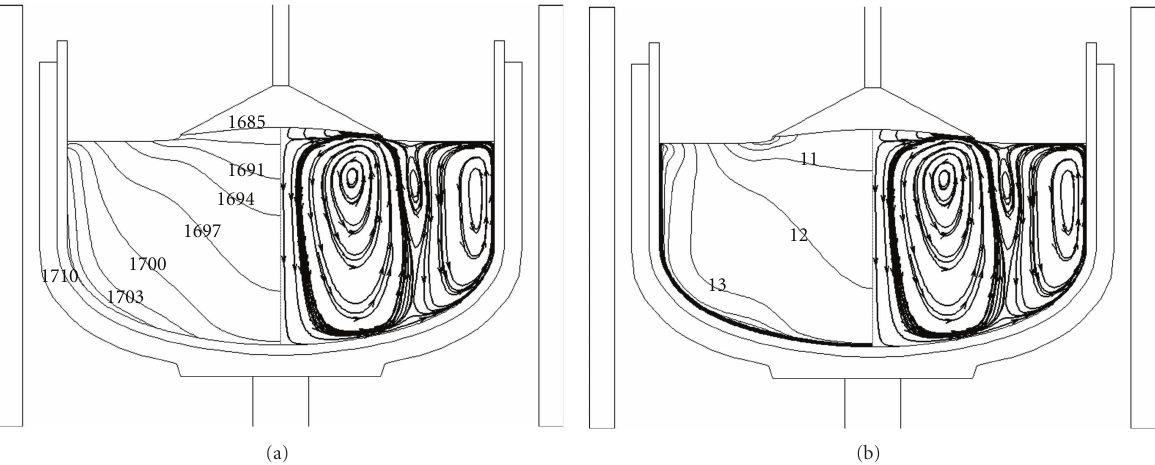
Figure 4: Distribution of temperature, streamtrace, and oxygen concentration in the melt for L = 50mm in a conventional CZ furnace ( h = 50mm): (a) isothermal lines (left) and streamtraces (right); (b) oxygen concentration isolines (left) and stream traces (right). The units of temperature, velocity vector, and oxygen concentration are K, m/s, and ppma, respectively. The spacing of the isothermal lines and concentration isolines are 3 K and 1ppma,